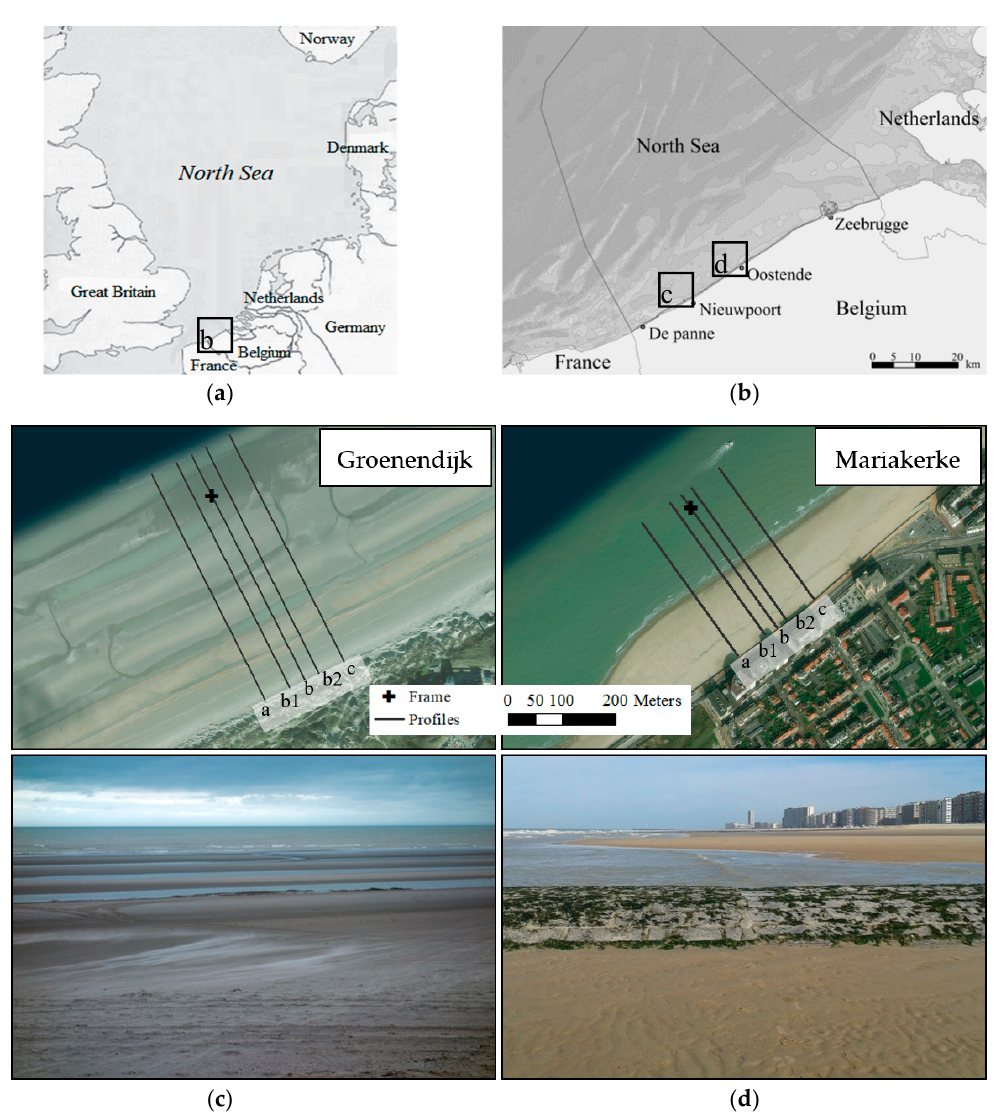
Figure 1. ( a , b ) Overview maps of the North Sea and the Belgian coast. ( c , d ) Ground pictures and maps of the intertidal beach at Groenendijk (c) and Mariakerke (d) with the intertidal frame and cross-shore topographic profiles indicated.